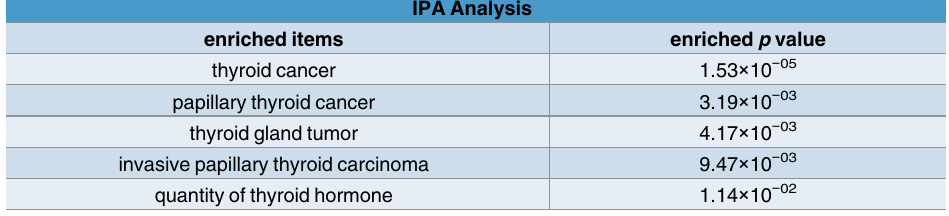
Table 5. The functional enrichment of sDNB genes in at least 50% of samples for